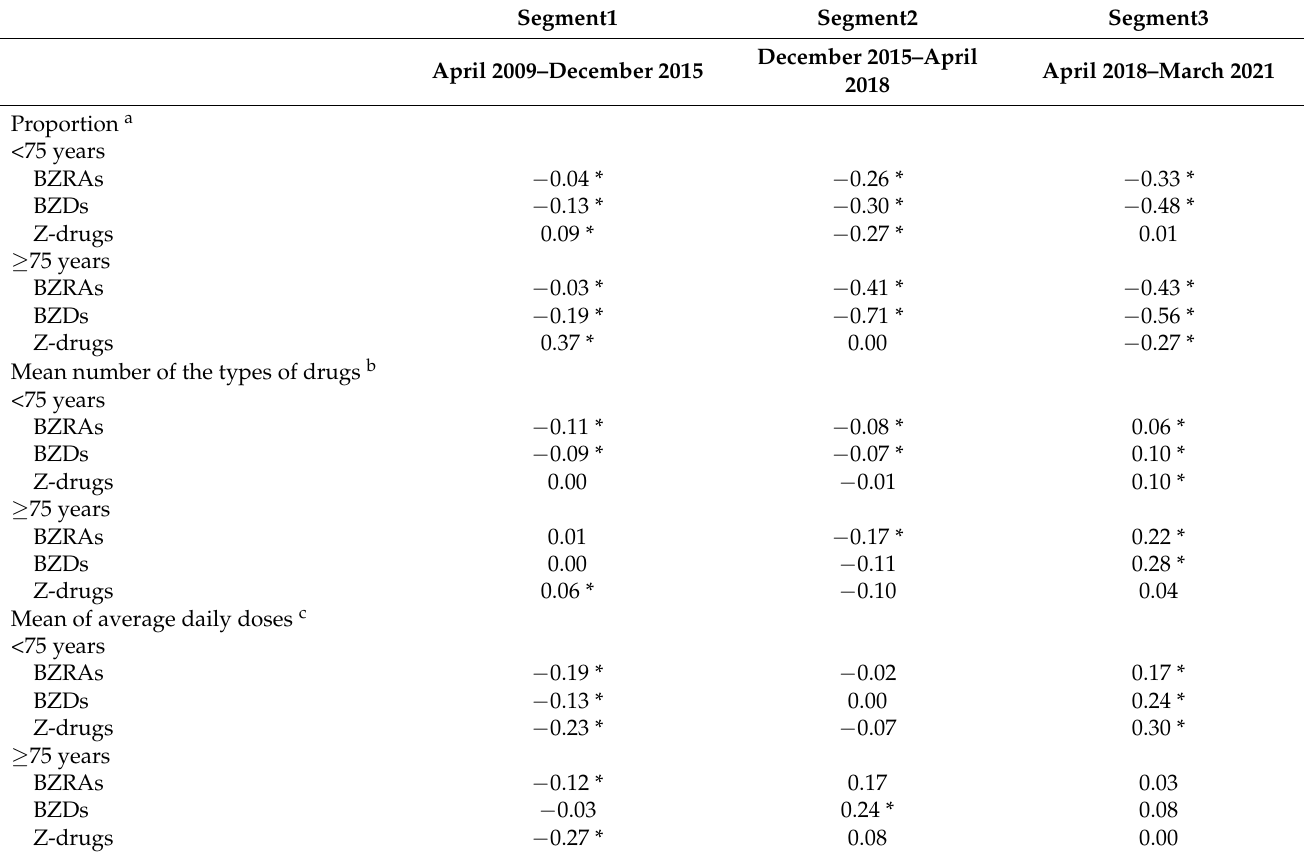
Table 2. The results of MPC by segments for each outcome indicator, drug type, and age